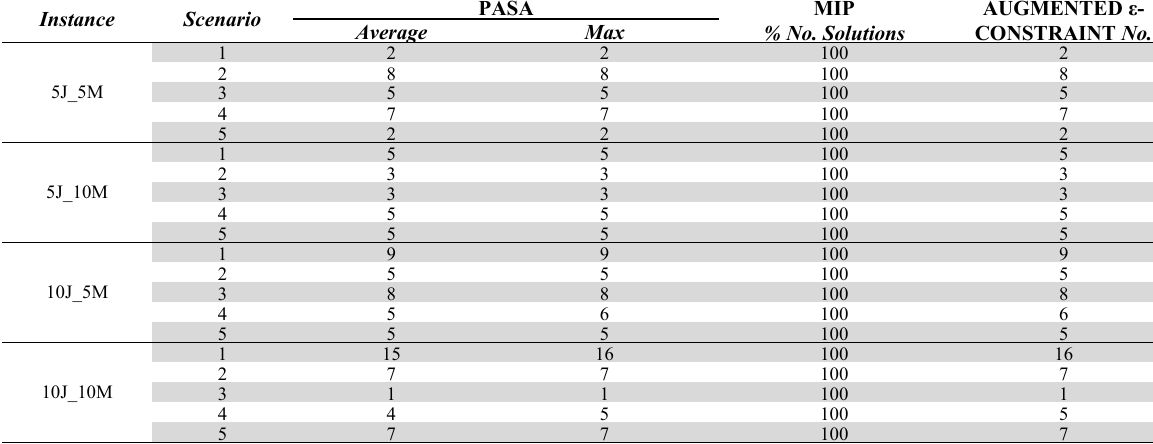
Results of Pareto efficiency tests for PASA’s solutions